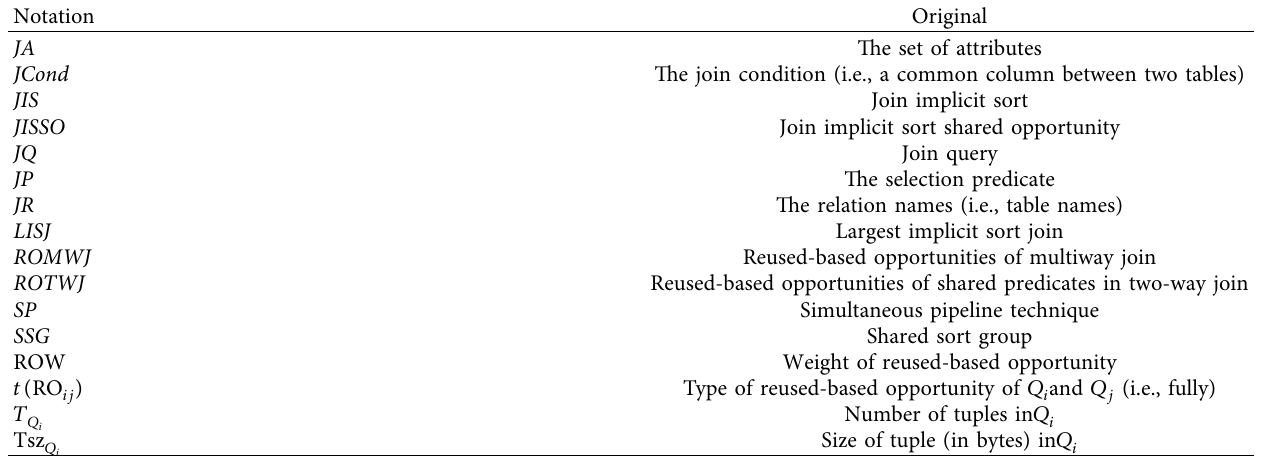
Table 2: List of